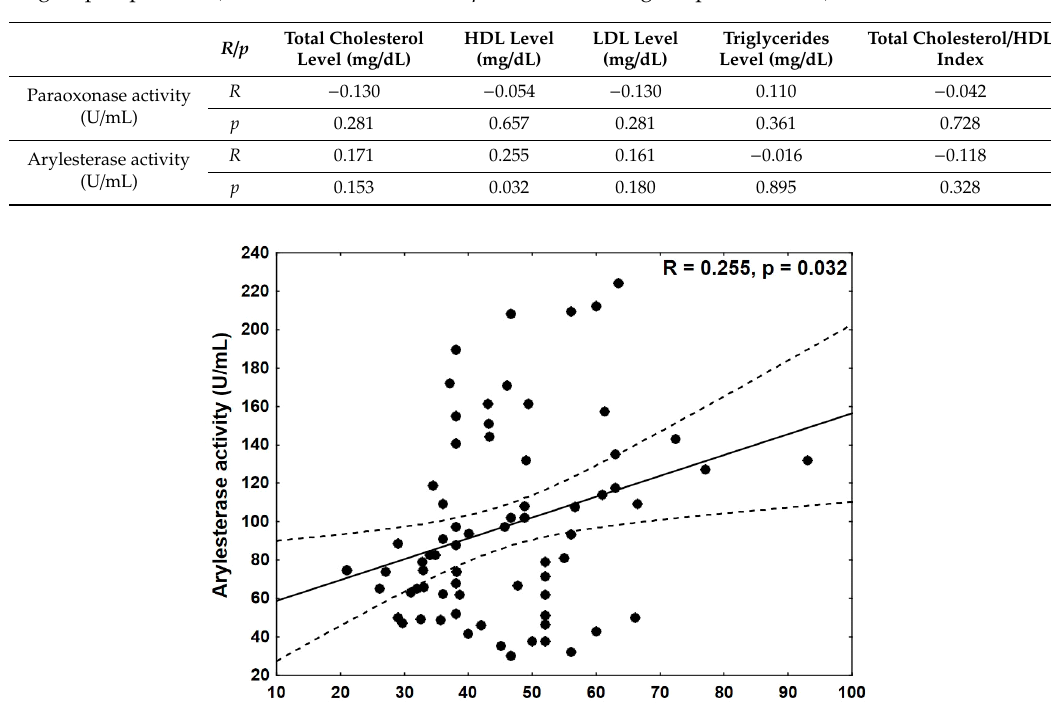
Table 3. Correlation of PON1 activity towards paraoxon and phenyl acetate and serum lipid profile in group of patients ( R , correlation coefficient; p , value according to Spearman test).